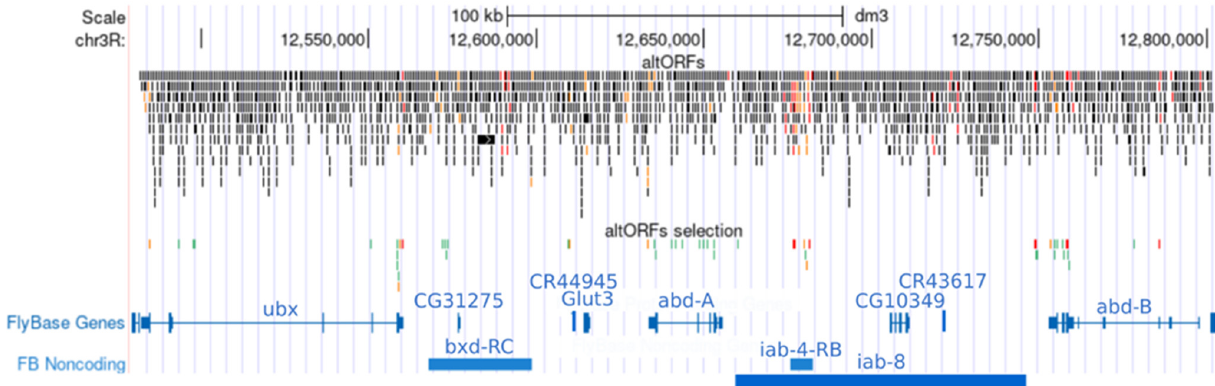
Figure 2. Distribution of the predicted altORFs in the BX-C region. Each altORF is represented as a small bar. The initial (2086, upper lines) and final (48, lower lines) number of predicted altORFs is shown. altORFs that have previously been identified are highlighted in red [33] or orange [35]. lncRNAs (blue bars) and CDS (blue lines with UTRs and exons) are indicated.